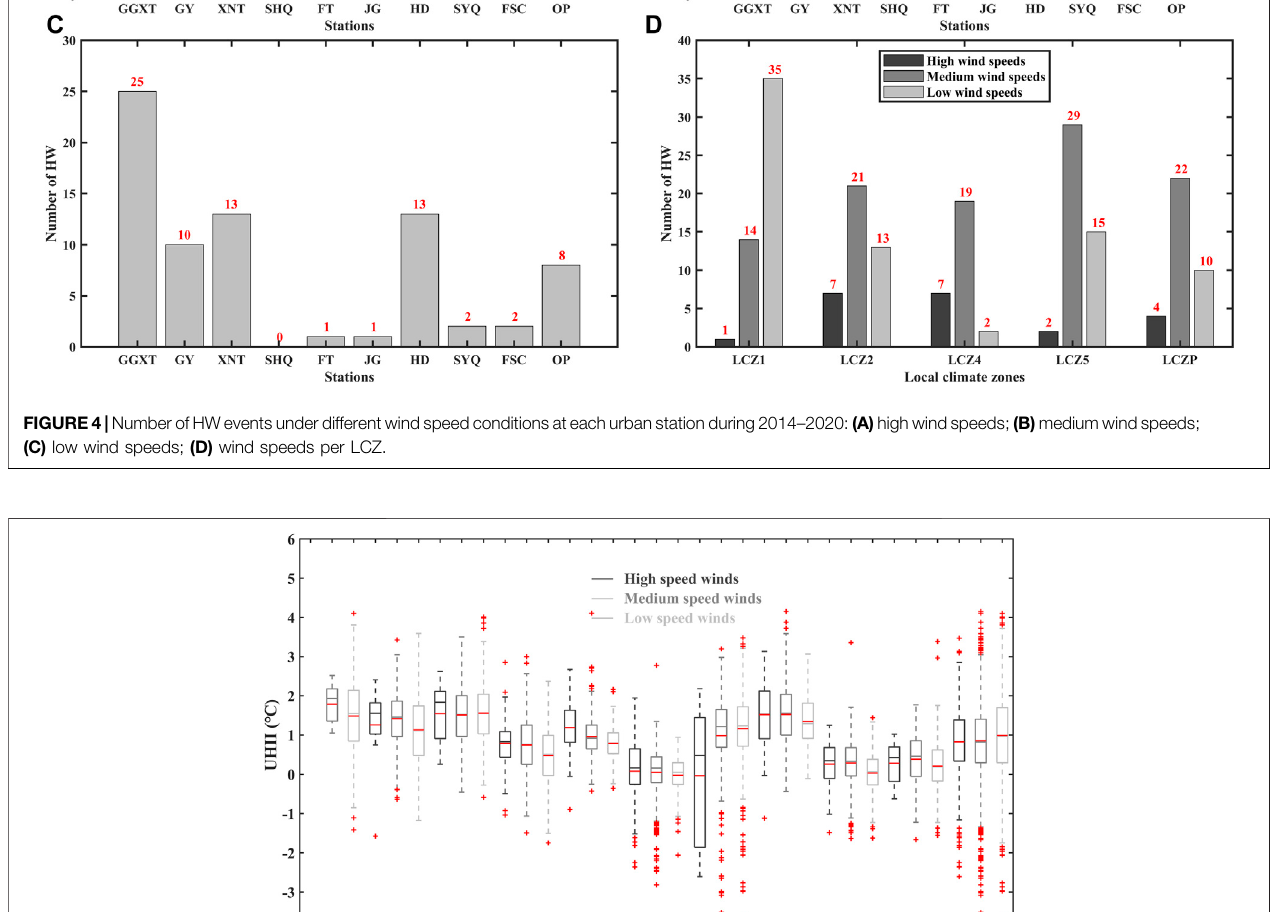
the smaller threshold difference between the low and medium wind speed categories.